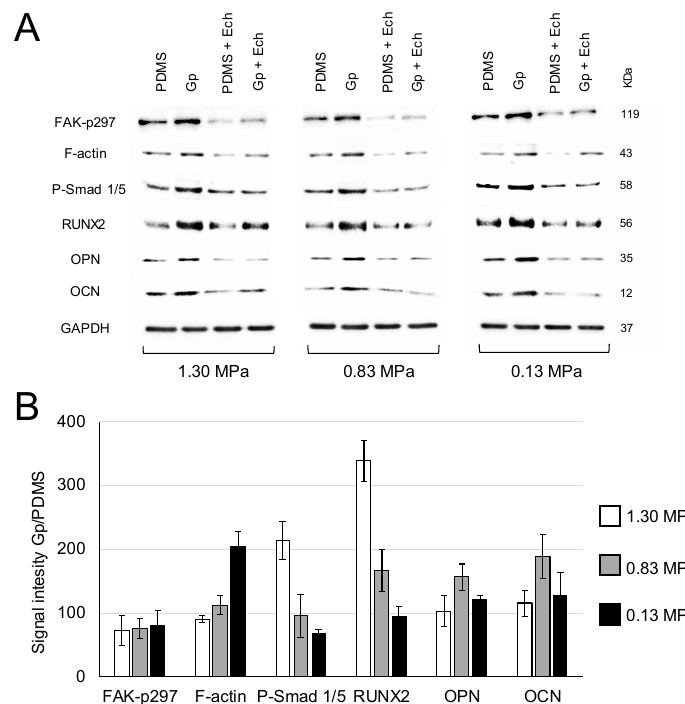
Figure 2. Effects of mechanotransduction inhibitors on cell proliferation. All inhibitors concentrations decreased cell proliferation at all time points compared to controls. After seven days, the proliferation decreased by approximately 30%, when cells were treated with 10 nM of echistatin ( A ) and 50 µM of Y27632 and DMH1 ( B , C ) comparing to the untreated control. (* denotes statistical difference between the groups, p < 0.05. For the sake of clarity, only the statistical significances at day seven are depicted).